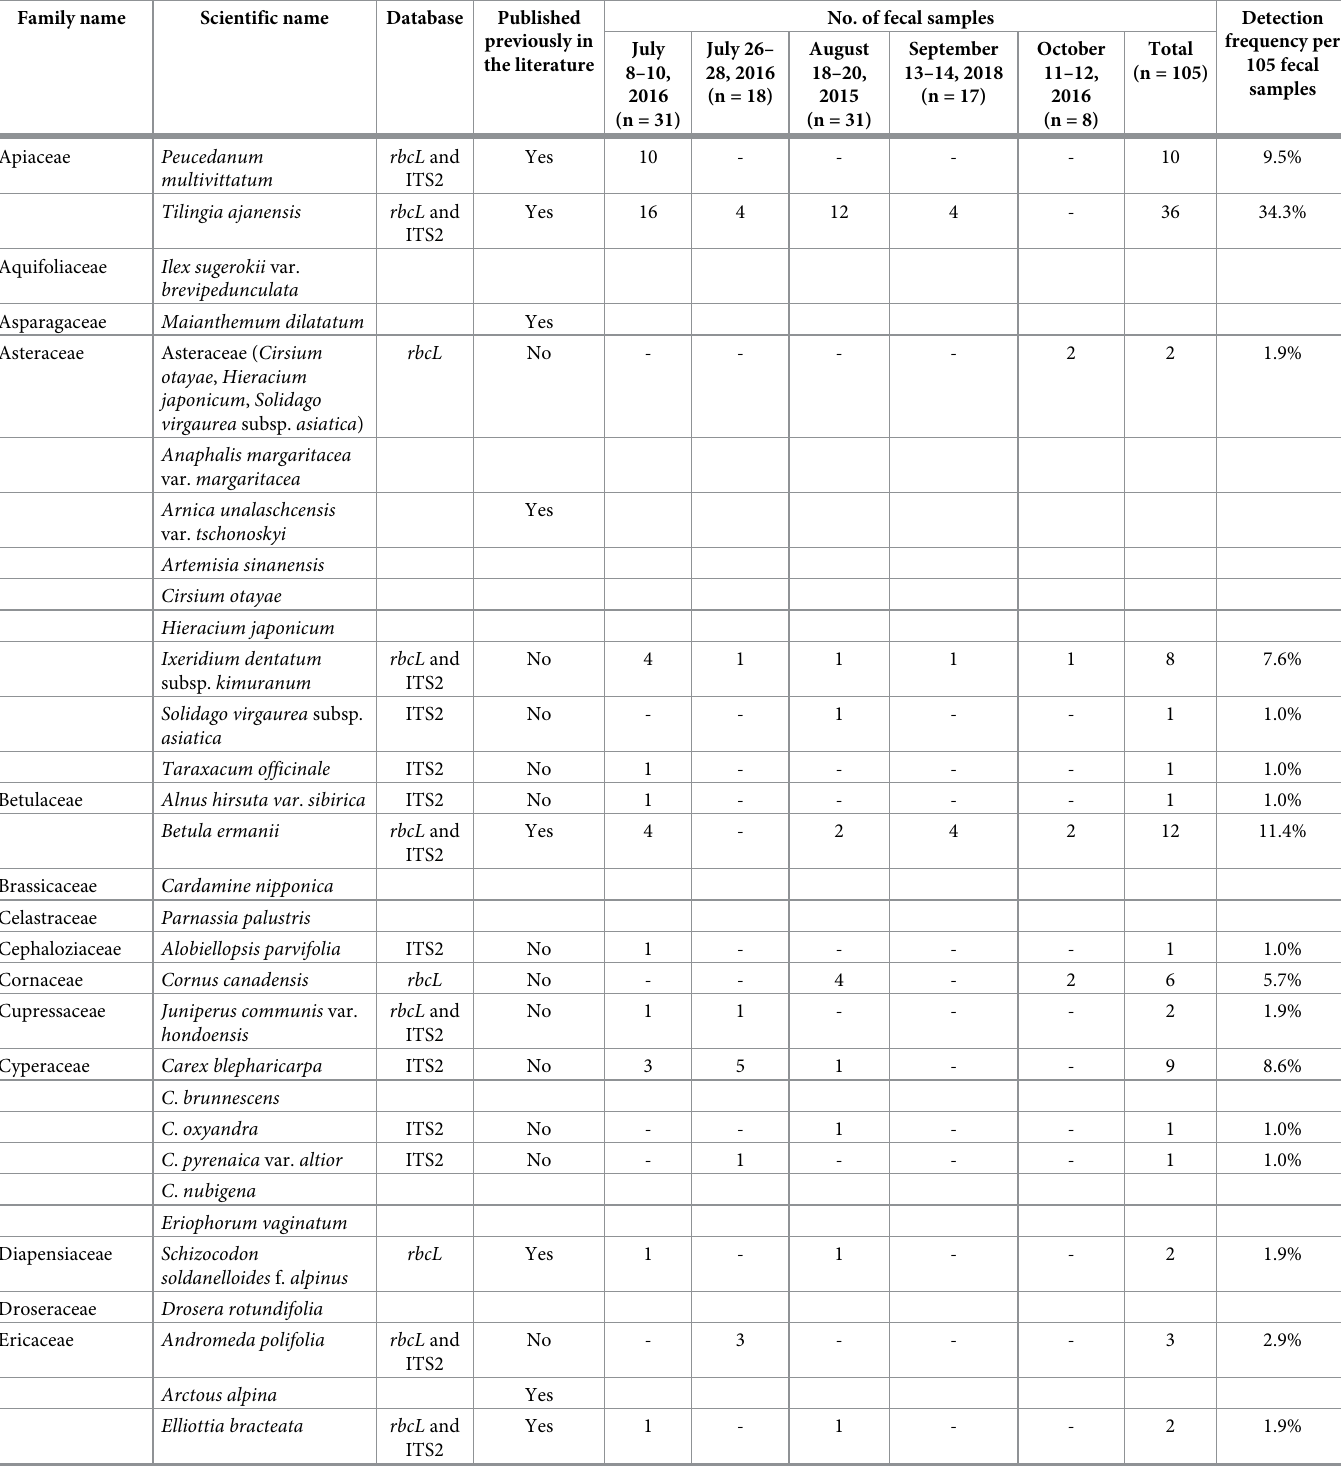
Table 4. Food plant taxa identified using DNA metabarcoding with rbcL and ITS2. Family